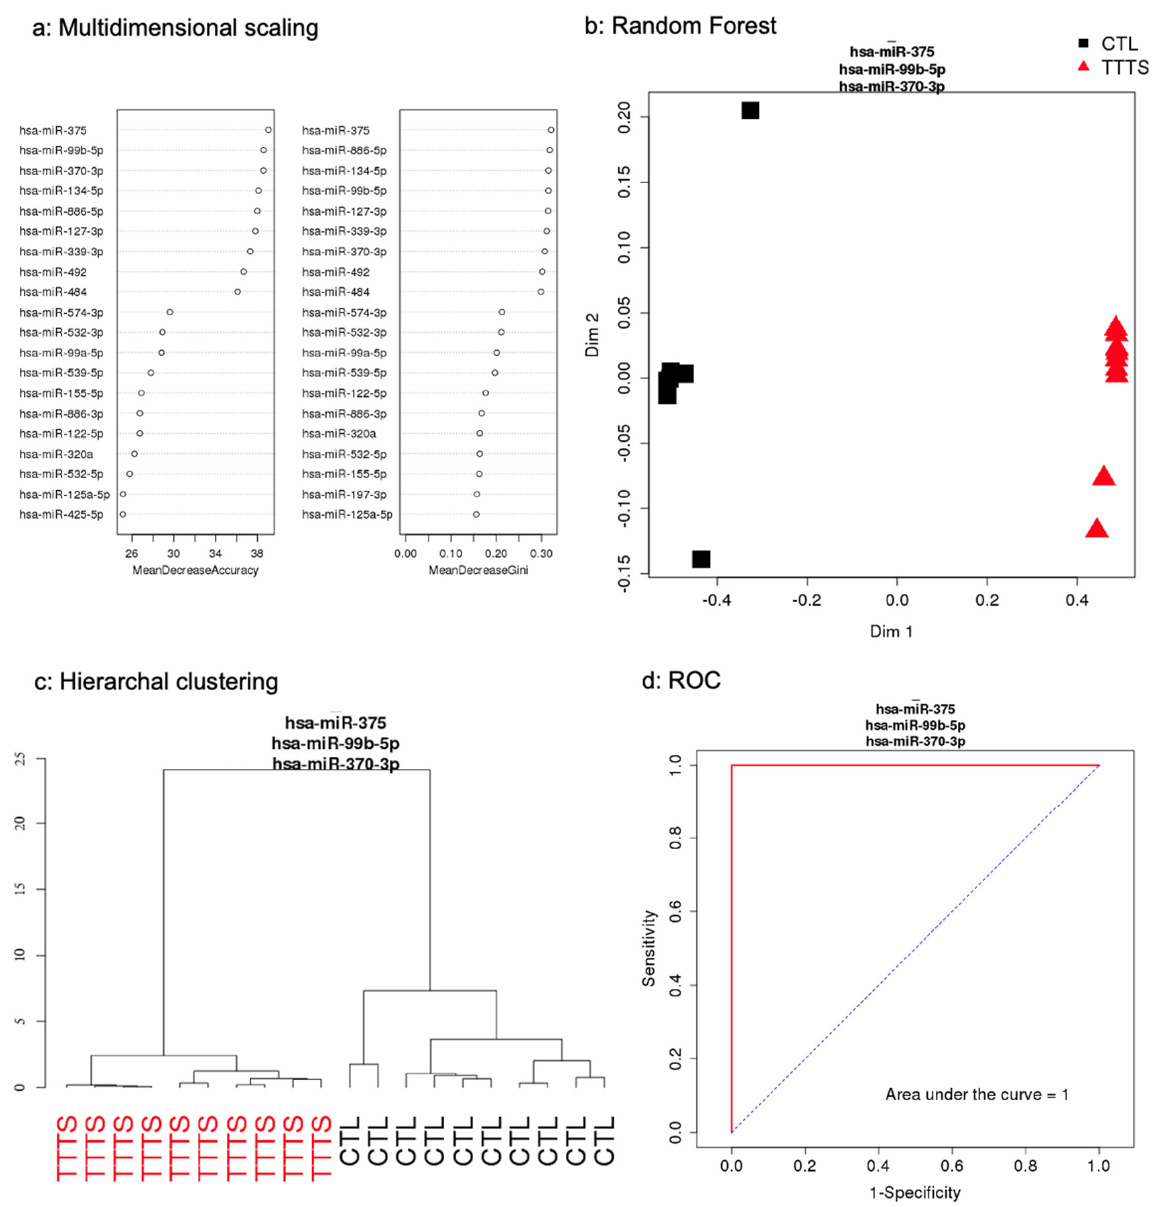
Figure 2. Amniotic fluid miRNAs differentiated TTTS subjects ( n = 10) from singleton controls ( n = 10). ( a ) Rank of most important miRNAs by multidimensional scaling. ( b ) Random forest (RF) analysis demonstrated that miR-99b, miR-370 and miR-375-3p differentiated the two groups. ( c ) Hierarchal clustering showed separation between the TTTS and controls. ( d ) Receiver operating curves using the top 3 miRNAs showed an area under the curve of 1.